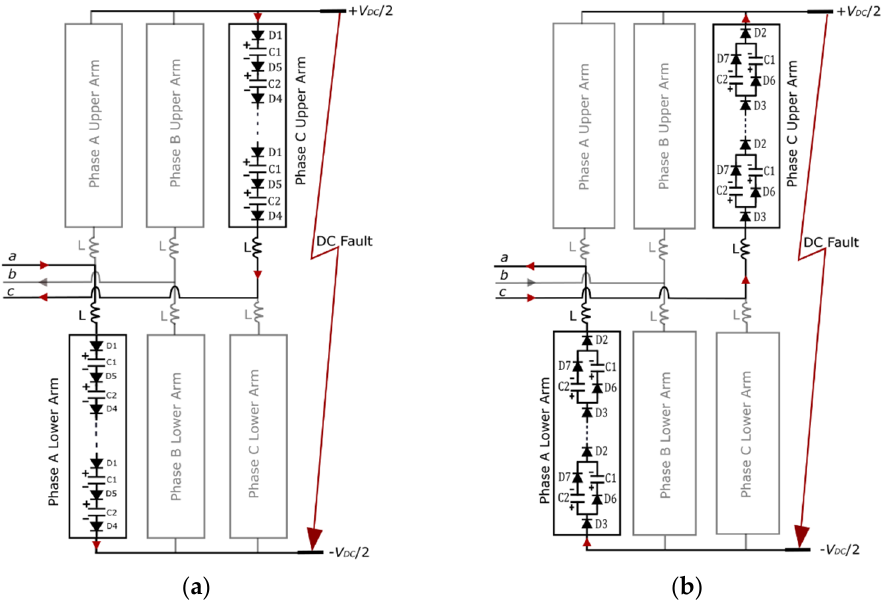
Figure 11. Fault current path for pole-to-pole fault in the CDSM-MMC, showing one phase for ( a ) 𝑖 (cid:3046)(cid:3040) > 0 and ( b ) 𝑖 (cid:3046)(cid:3040) < 0. ( a ) i sm > 0 and ( b ) i sm <